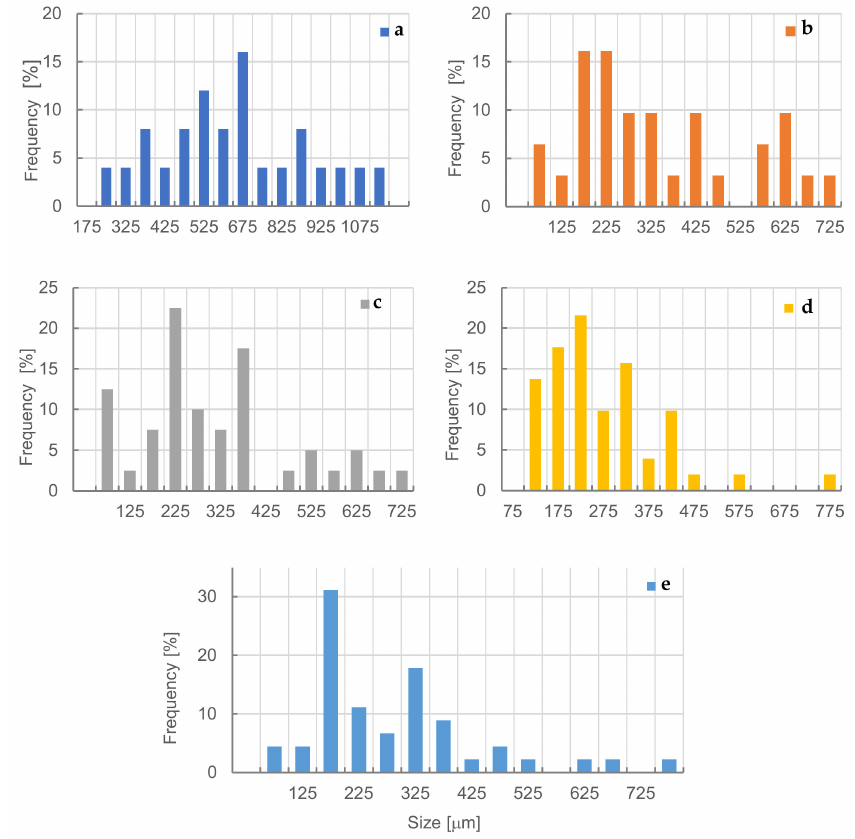
Figure 4. Frequency of occurrence of different cell sizes in PUR-WP composites. ( a ) reference sample; ( b ) 0.05–<0.125 mm; ( c ) 0.125–<0.315 mm; ( d ) 0.315–1.25 mm; ( e ) >1.25–2.0